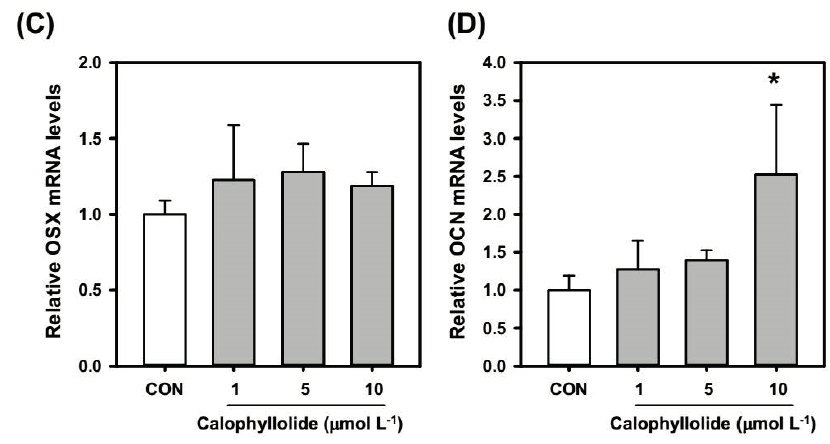
Figure 5. Effects of calophyllolide on osteogenic mRNA expression in MC3T3-E1 cells. After treated cells with calophyllolide (1, 5, and 10 μ mol·L − 1 ) for 4 days, total RNA was